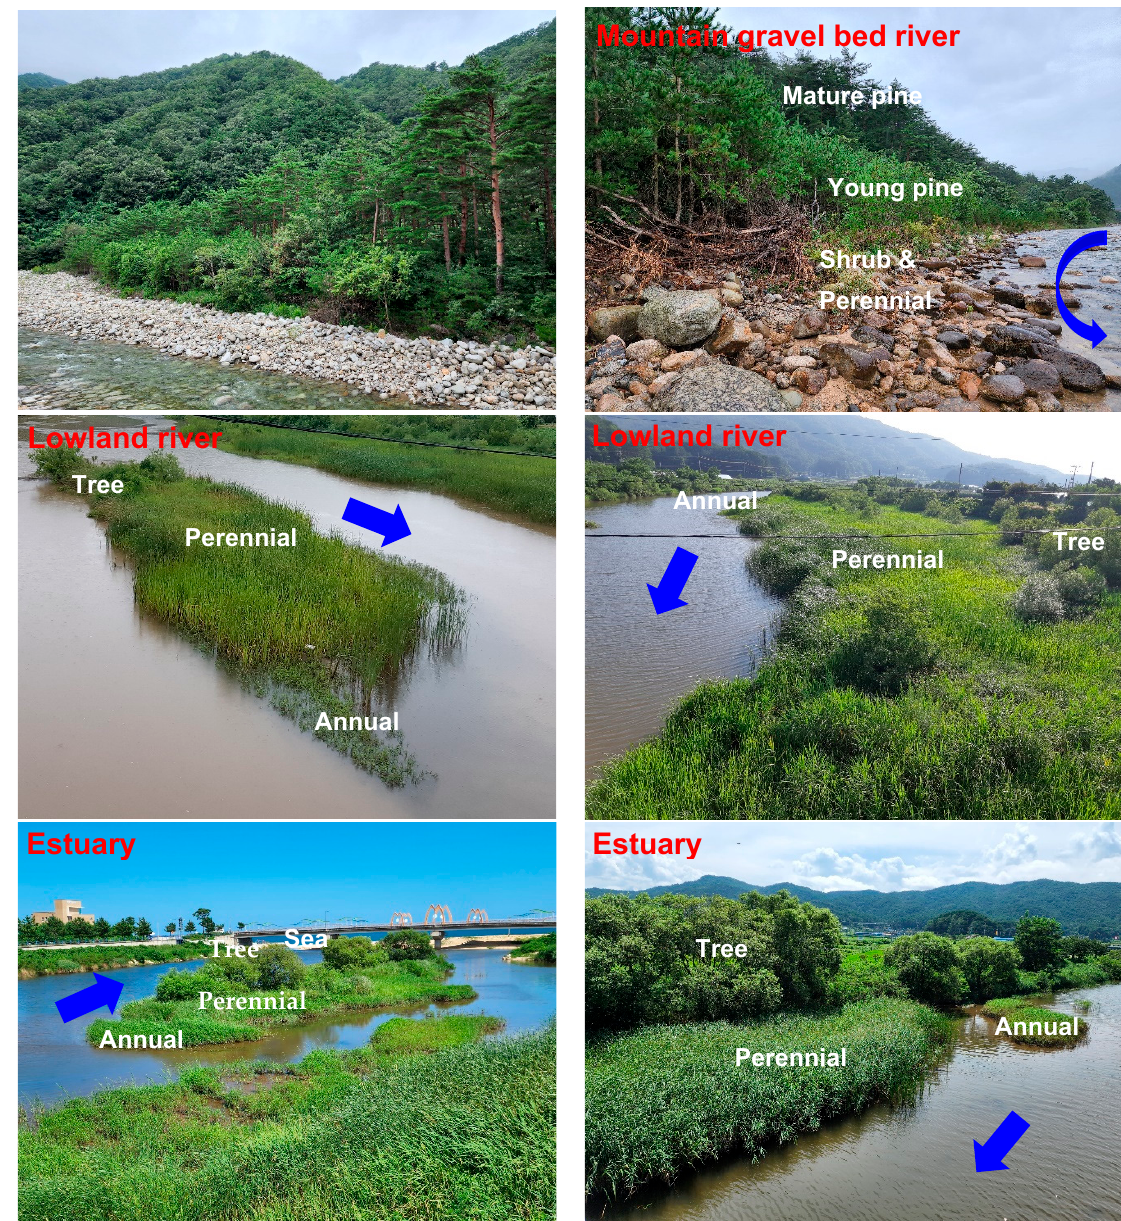
Figure 1. A map showing the study areas. A1: gravel bar of mountain gravel bed river, A2: riparian zone of mountain gravel bed river, B1: sand bar of lowland river, B2: riparian zone of lowland river, C1: sand bar of estuary, C2: riparian zone of estuary.